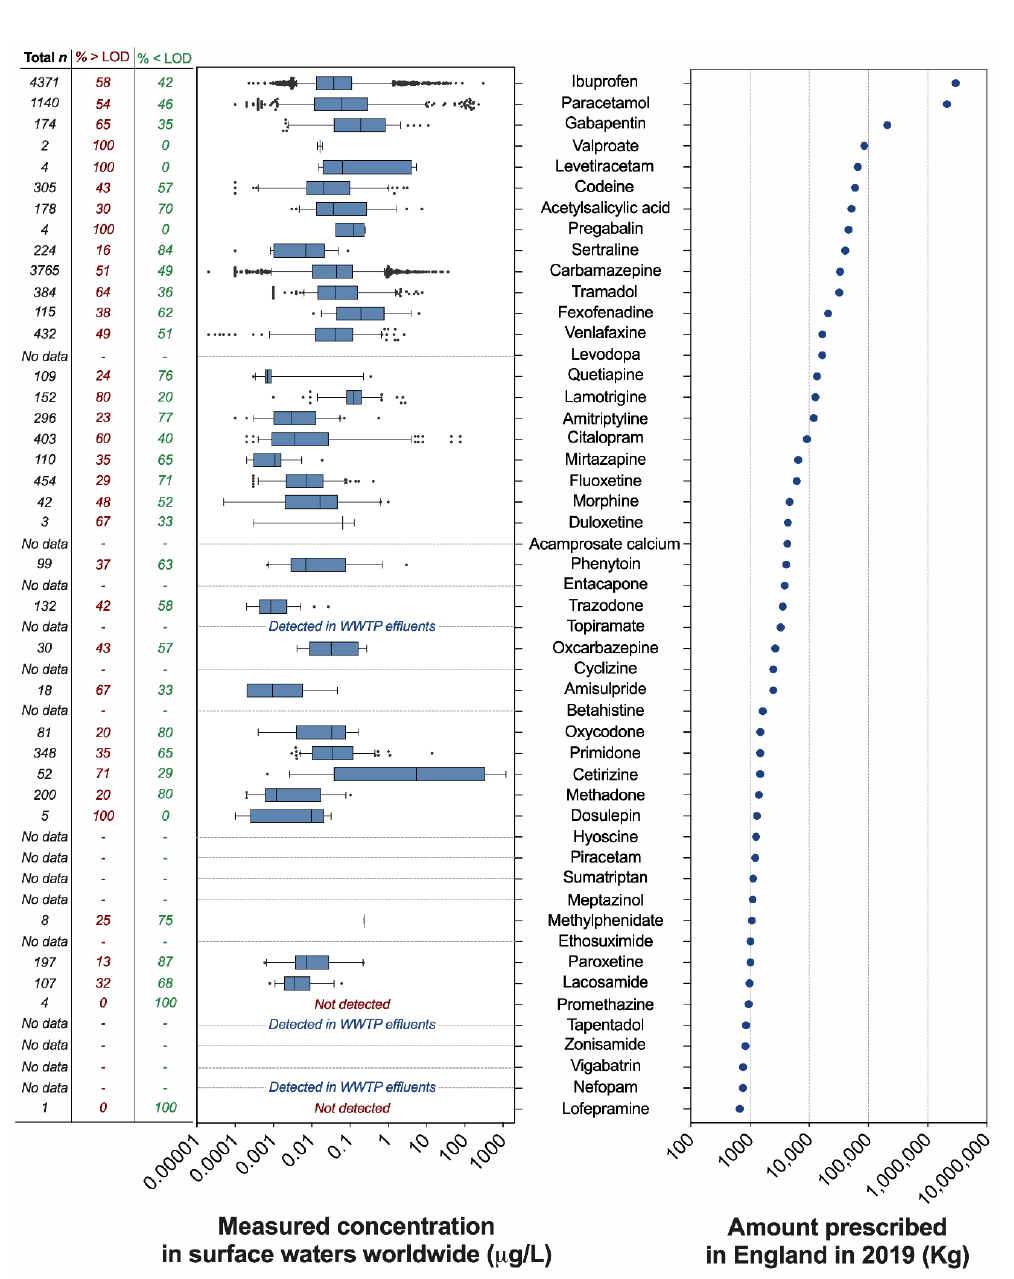
Figure 1. Top 50 neuroactive pharmaceuticals dispensed in England and their concentrations in surface waters worldwide. ( Left panel ) Measured concentrations of neuroactive pharmaceuticals in surface waters worldwide ( µ g/L). The range of concentrations is visualised as box plots, where the limits indicate the 5th and 95th percentiles of the data distribution. Data points outside this range are visualised as individual dots. The vertical line in each box indicates the median value. The data were extracted from the PHARMS-UBA database curated by the German Environment Agency (Umweltbundesamt–UBA) and represent only the values generated by scientific reports classified as “good literature credibility” by the database curators. For each pharmaceutical, the figure indicates the number of available datapoints in the database (first column), the percentage of data above the limit of detection (second column), and the percentage of data below the limit of detection (third column). ( Right panel ) Top 50 neuroactive pharmaceuticals prescribed in England in 2019 and ranked by dispensed amount (kg). The data were generated by analysing the Prescription Cost Analysis (PCA) report (year 2019) provided by the National Health Services (NHS) of England (United Kingdom) and published by the NHS Business Services